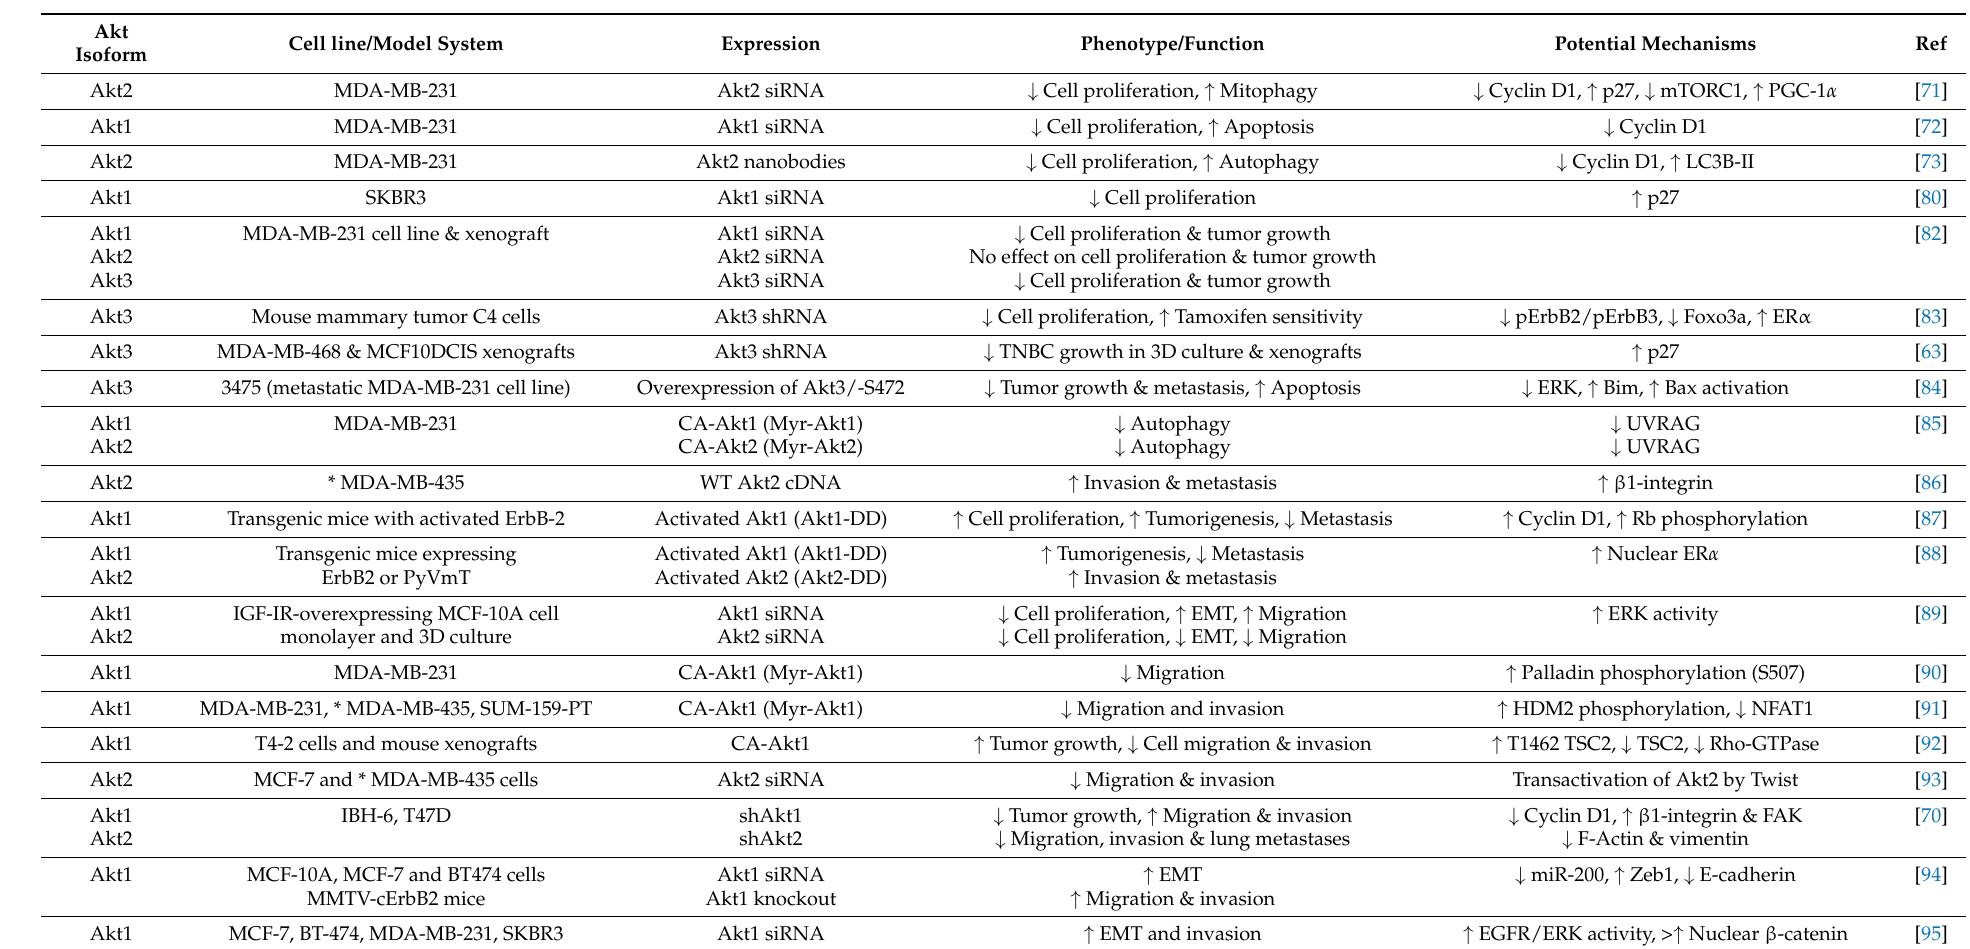
Table 1. Function of Akt